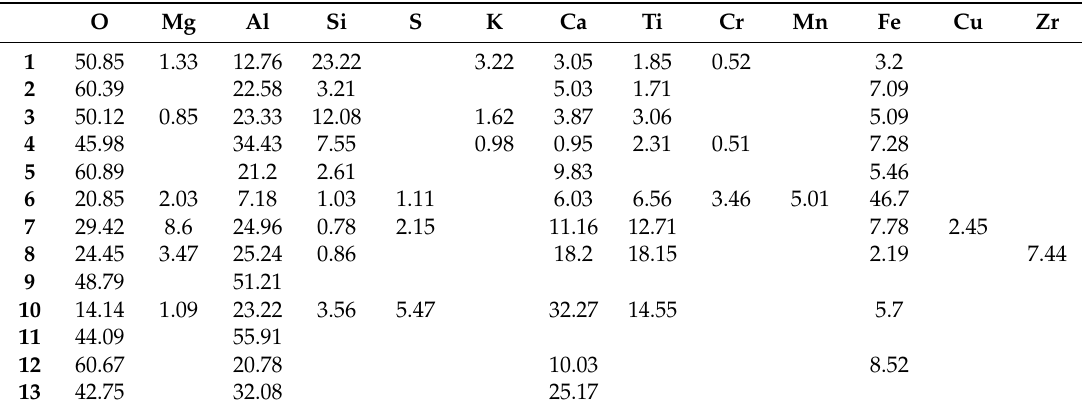
Table 3. Composition analysis of each inclusion in Figure 8, wt-%.